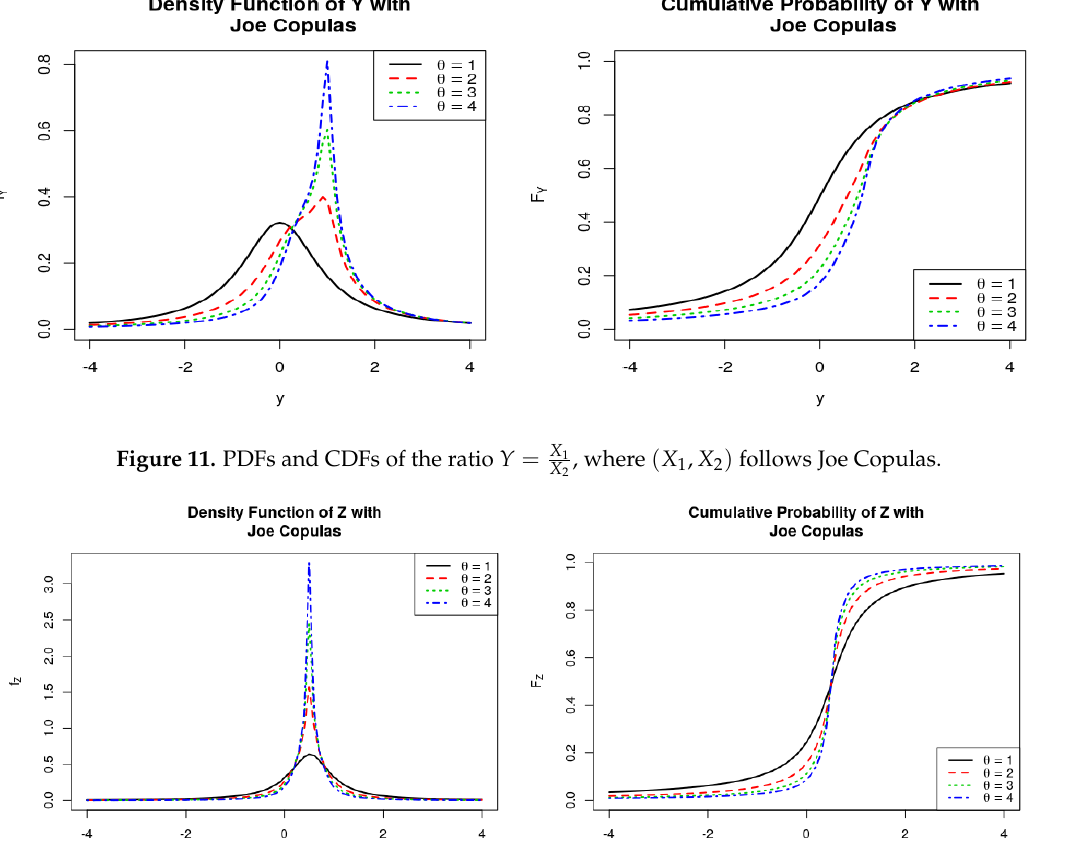
Figure 12. PDFs and CDFs of the ratio Z = X 1